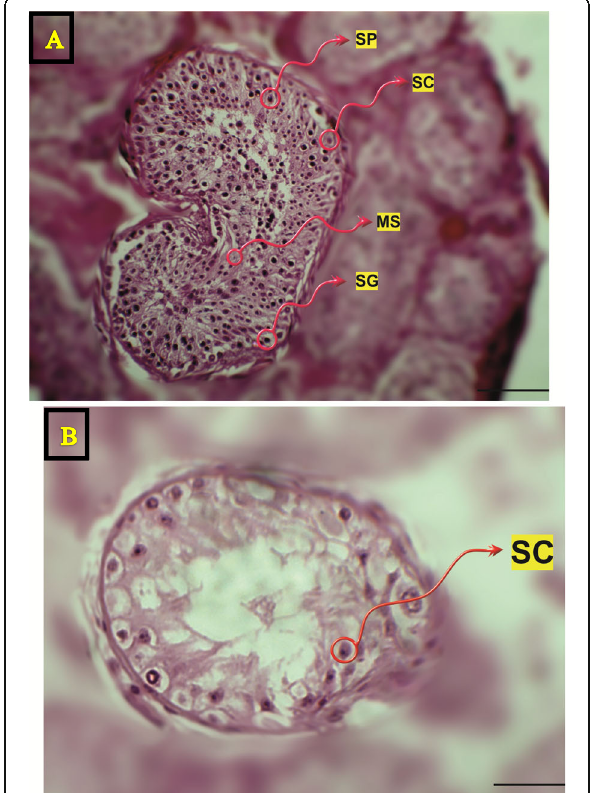
Fig. 1 a Testicular sections of samples with OA (obstructive azoospermia). b Testicular segments of specimens by SCOS (Sertoli cell-only syndrome). SP = spermatocyte; MS = mature spermatid; SC = Sertoli cell; SG = spermatogonia; Scale bar = 20 μ